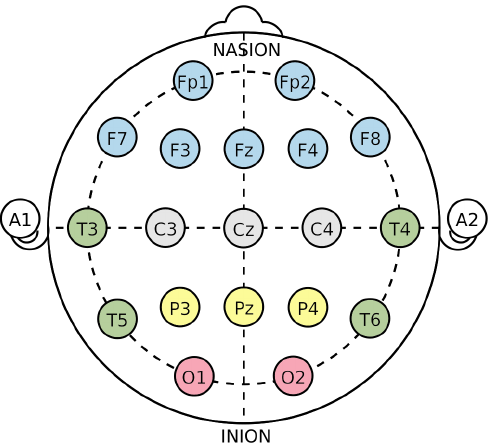
Figure 3. 10-20 International system (adapted from https://commons.wikimedia.org/w/index.php? curid=10489987 accessed on 31 January 2023). The letter correspondences are as follows: frontopolar (Fp), frontal (F), central (C), parietal (P), occipital (O), temporal (T). Auricular (A) electrodes are also